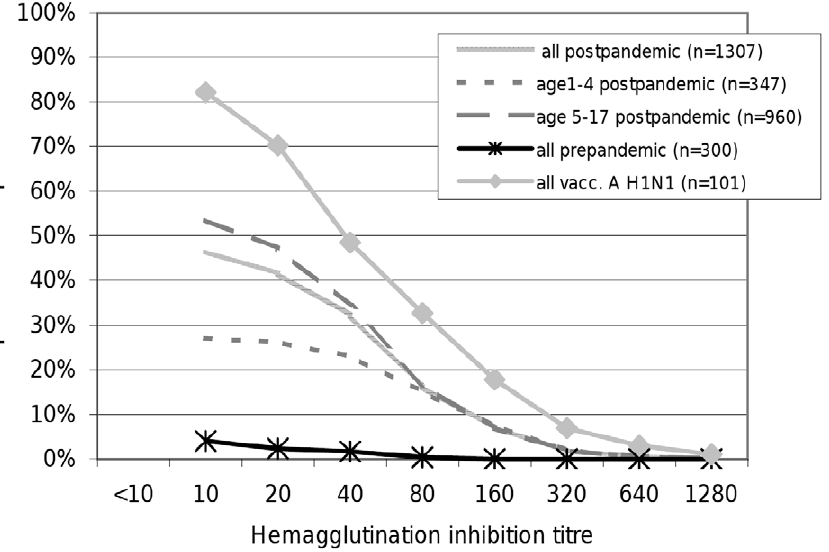
Figure 1. Reverse cumulative distribution curves of hemagglutination inhibition titers for antibodies against influenza A (H1N1) 2009 virus for different strata. Post-pandemic children not vaccinated against influenza A (H1N1) 2009 aged 1–17, thereof 347 aged 1–4 and 960 aged 5–17 were tested and in addition 300 pre-pandemic controls and 101 children vaccinated against influenza A (H1N1) 2009. Children aged 1–4 exhibit lower titers compared to children aged 5–17 and all post-pandemic cases. Titers of pre-pandemic children aged 1–17 are distinctly lower. Children vaccinated against A (H1N1) 2009 exhibit higher titers compared to post-pandemic children having been infected with A (H1N1). doi:10.1371/journal.pone.0023955.g001 PLoS ONE |